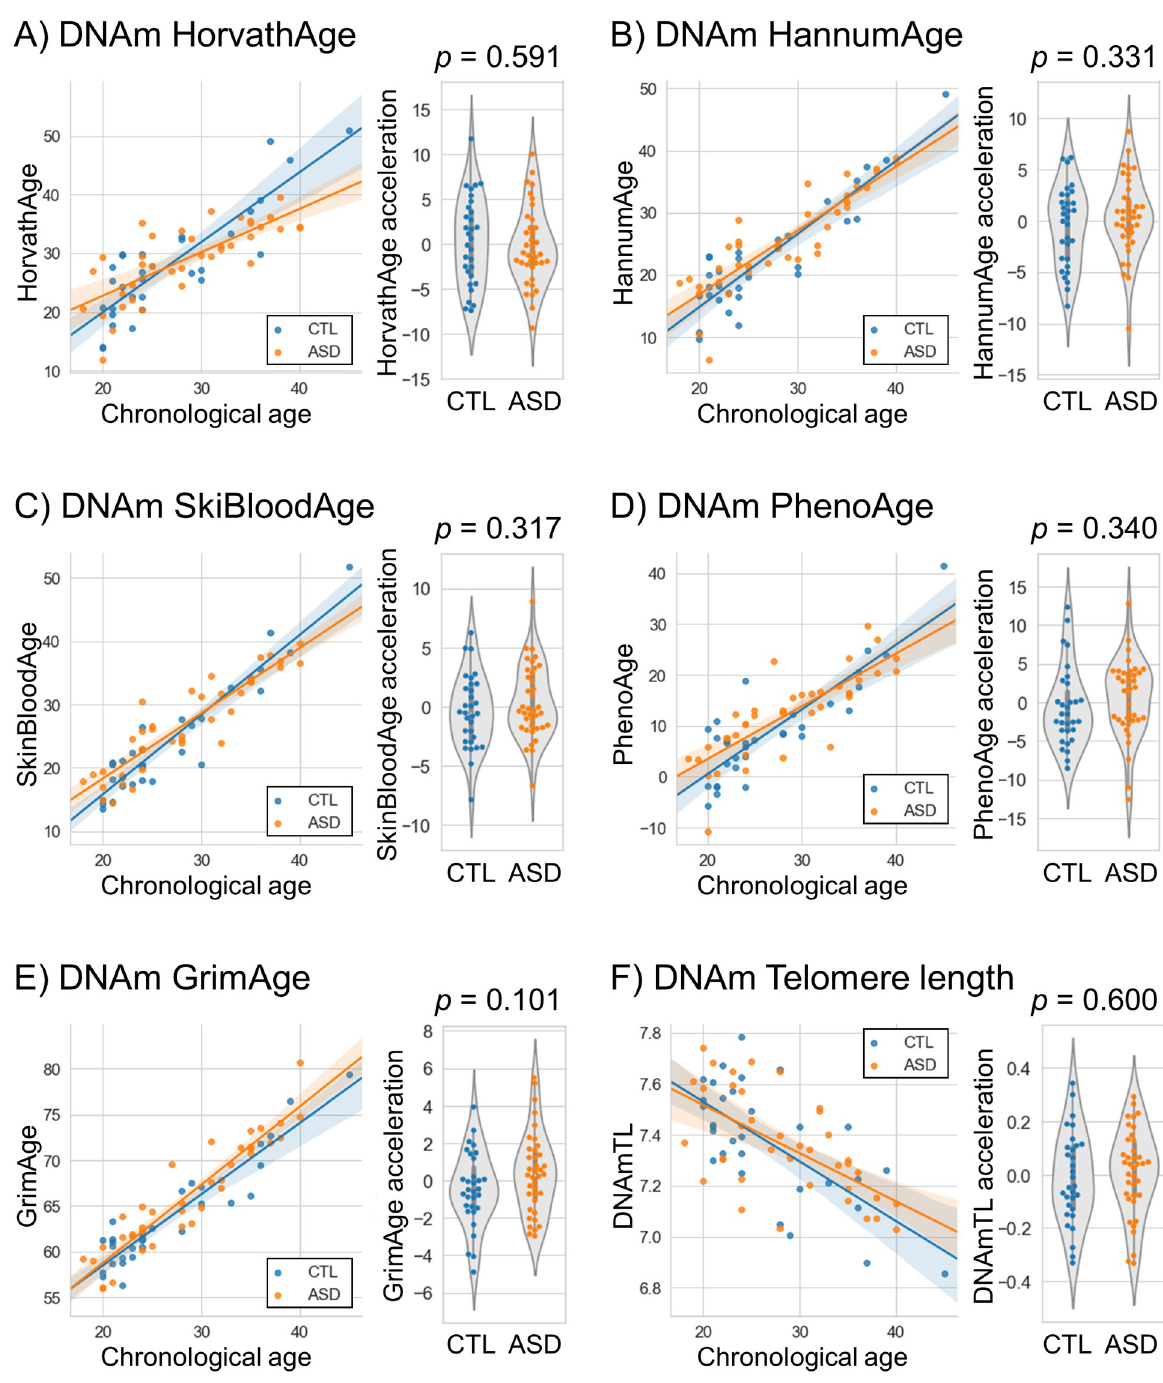
Fig 1. Epigenetic clock analysis in the 1st cohort. ( A ) HorvathAge, ( B ) HannmuAge, ( C ) SkinBloodAge, ( D ) PhenoAge, ( E ) GrimAge, and ( F ) DNAmTL. Scatter plots show epigenetic age vs. chronological age. Violin plots with dots show epigenetic age acceleration in the ASD and control groups. Student’s t -tests were performed for comparisons between the groups. ASD, autism spectrum disorder; CTL, control; DNAmTL, DNA methylation-based telomere length.